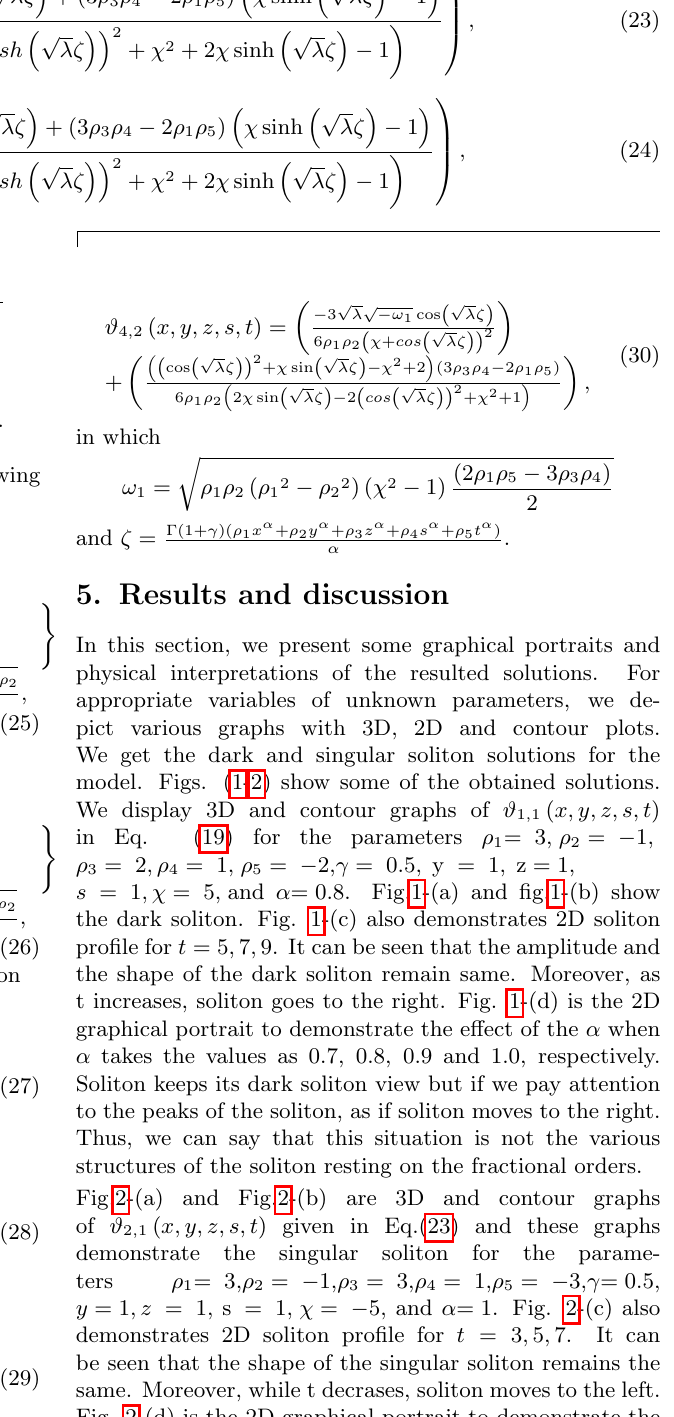
same. Moreover, while t decrases, soliton moves to the